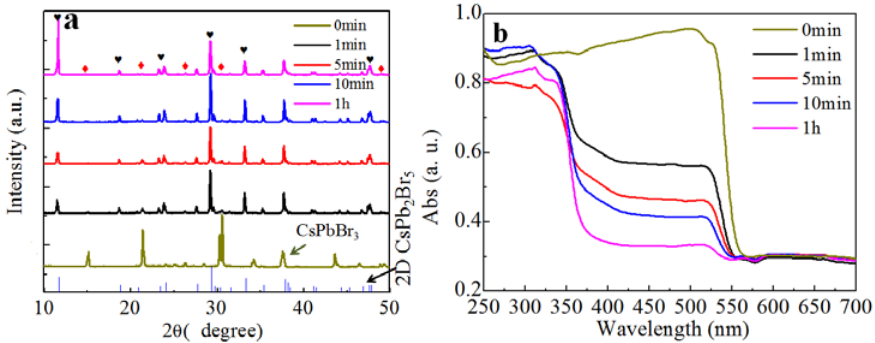
Figure 4. (a) XRD patterns and (b) absorption spectra of CsPbBr 3 solids after water treatment for different times. Red diamonds represent CsPbBr 3 and black hearts denote the diffraction peaks of CsPb 2 Br 5 .